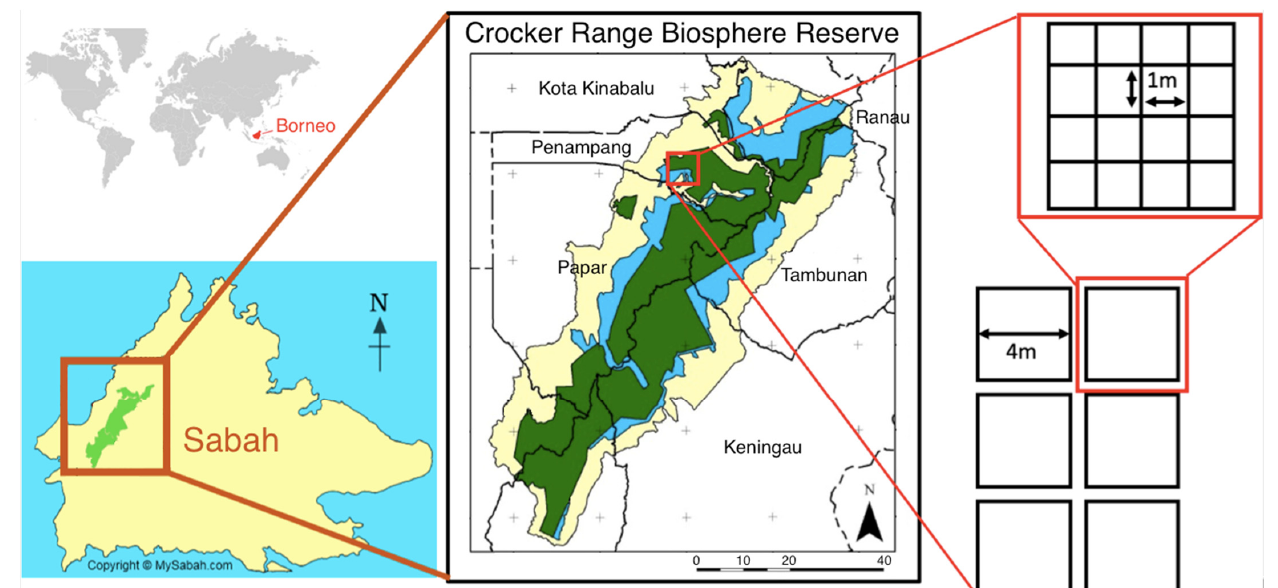
Figure 1. Location of study site within the Crocker Range Biosphere Reserve, Sabah, Malaysia. The study site encompasses both the core and buffer forest (green and blue respectively; center panel). Within each of the core and buffer zones, six 16 m 2 plots were established with 16 − 1 m 2 quadrats within for a total of 12 plots and 192 quadrats.